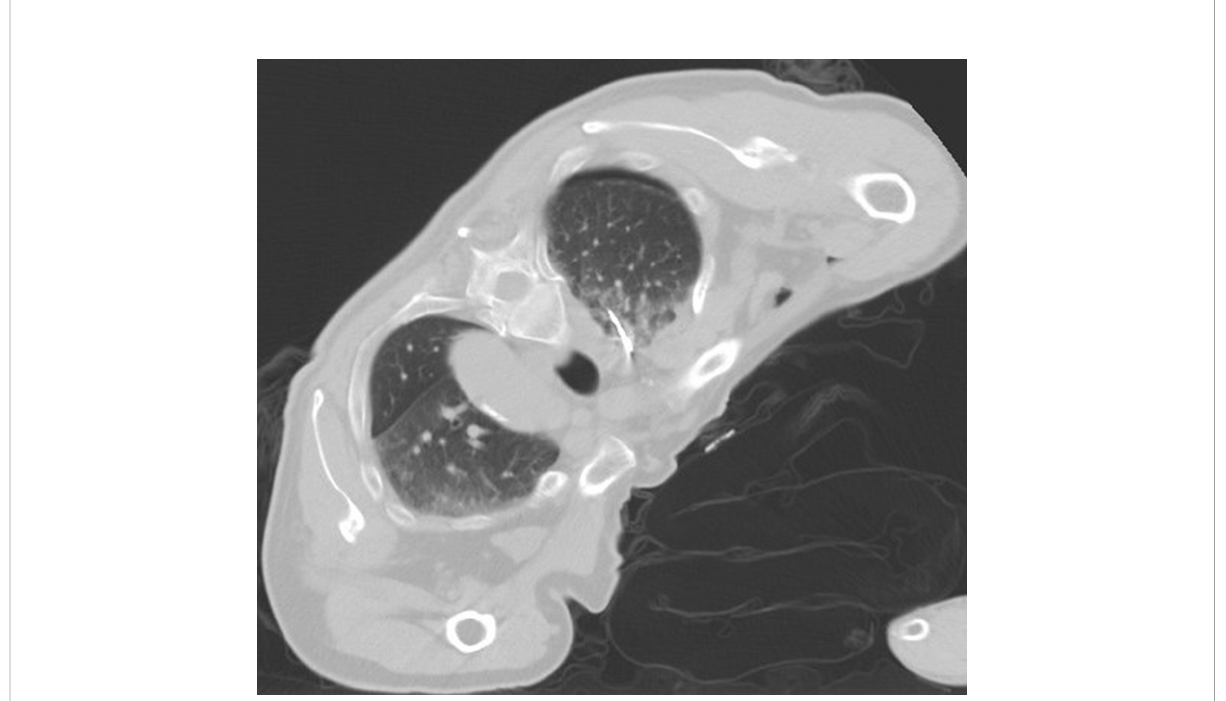
FIGURE 7 Guided by CT, the needle was gradually inserted through the microwave antenna to the bottom of the lesion for